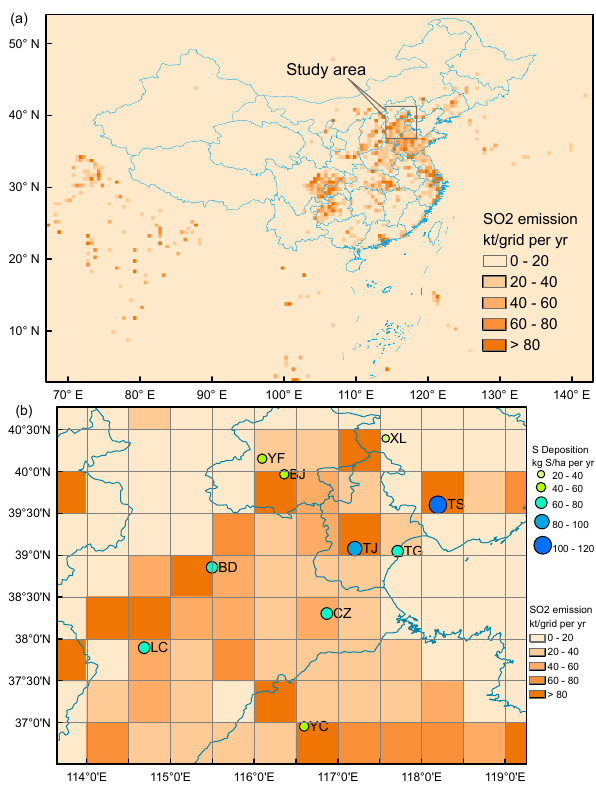
Fig. 1. Locations of the study area (a) and the sampling sites (b) in Northern China with SO 2 emission distributions. The total sul- fur deposition data are means of 3-yr observations from December 2007 to November 2010. The emission data of SO 2 are from 2006 (Zhang et al., 2009), with a resolution of 0.5 ◦ × 0.5 ◦ . The definition of the site codes is found in Sect.